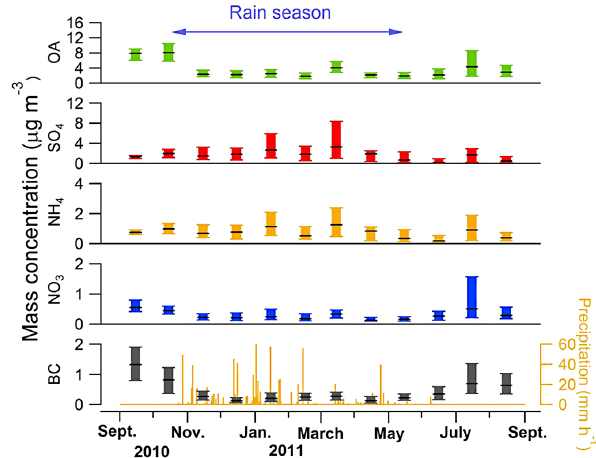
Fig. 3. Monthly median concentrations of OA, SO 2 − and BC, as well as rainfall intensities. The box plots indicate me- dian, as well as 25th and 75th